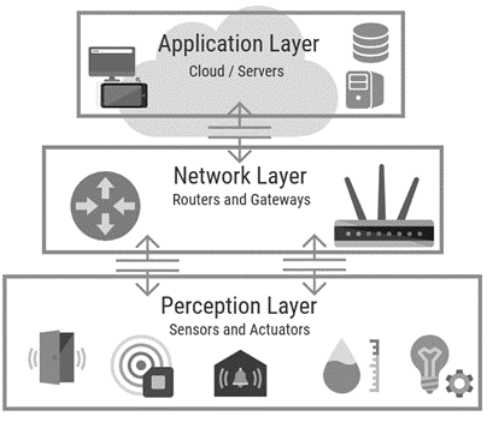
Figure 1. Iot 3 layer